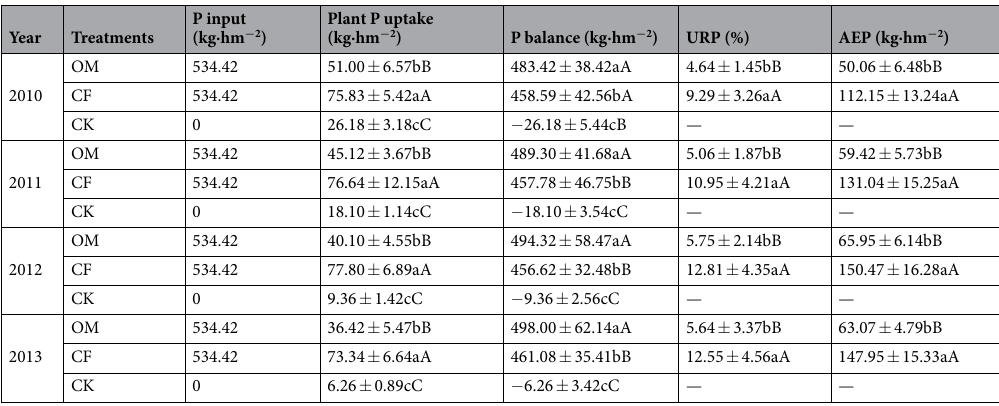
Table 3. The P balance, URP and AEP values under the different treatments. Note: The different lowercase and uppercase letters in the same column for each year indicate a significant difference at the 0.05 and 0.01 levels,